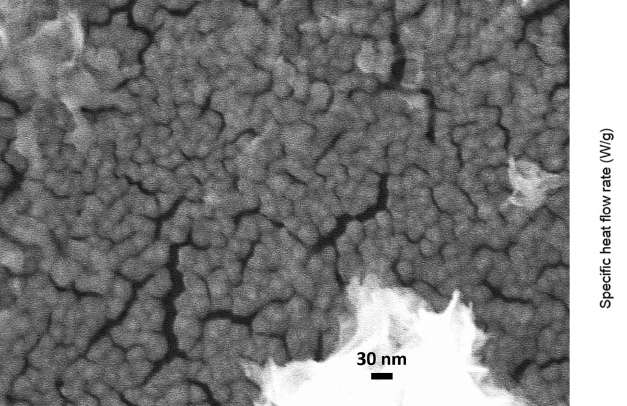
Figure 3: ASM image and XRD pattern of nanohydroxyapatite.